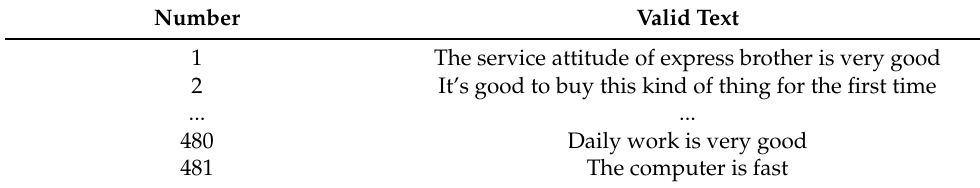
Table 2. Valid text set of Lenovo Xiaoxin chao 5000 (481 valid text).